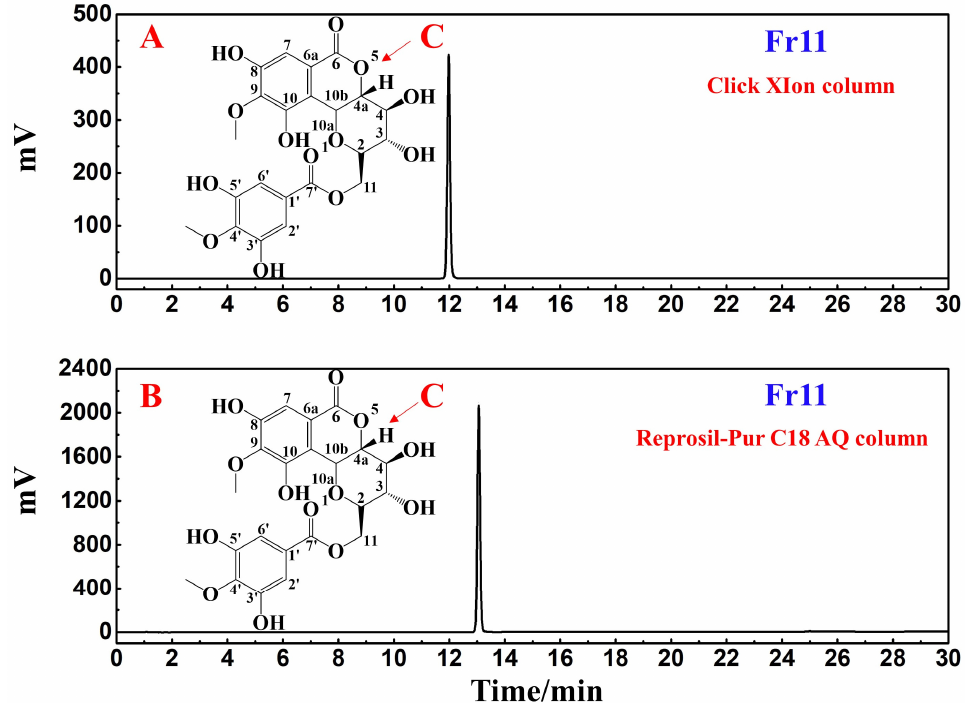
Figure 3. Analyses figures of the purity of the target compound in Fr11 were performed using Click XIon ( A ) and ReproSil-Pur C18 AQ ( B ) analytical columns. ( C ) shows the chemical structure of the isolated compound. Conditions: mobile phase A: 0.2% v/v formic acid in water and B: ACN; gradient: 0–30 min, 95–55% B for ( A ), 0–30 min, 5–50% B for ( B ); detection wavelength: 254 nm; flow rate: 1.0 mL/min; injection volume: 5 μ L; column temperature: 30 °C.